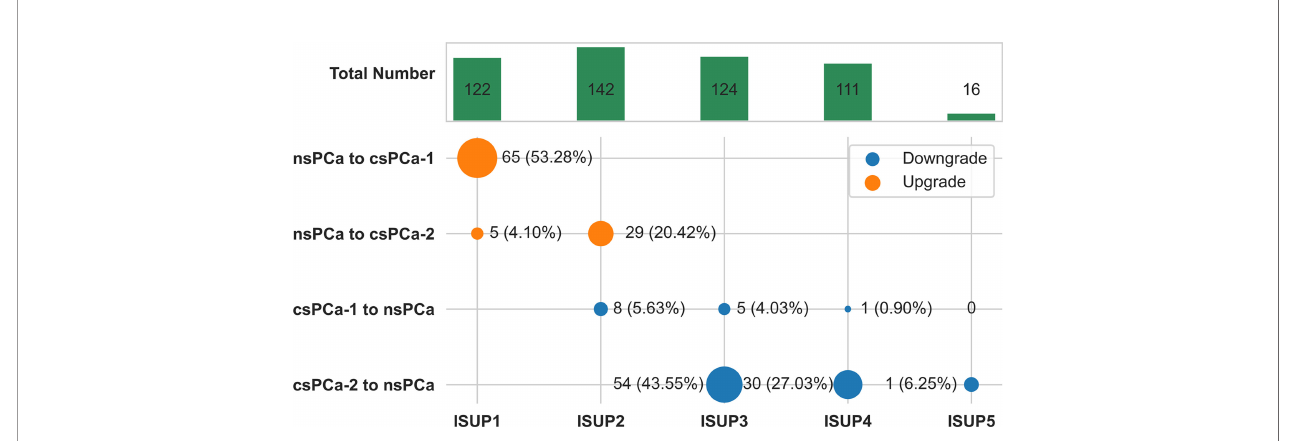
FIGURE 3 | Change plot of clinically signi fi cant pathological upgrade or downgrade from combined biopsy to fi nal radical prostatectomy according to ISUP grade group. csPCa-1 was de fi ned as ISUP grade group 2 or higher tumors. csPCa-2 was de fi ned as ISUP grade group 3 or higher tumors. The size of dot re fl ects the number.csPCa, clinically signi fi cant prostate cancer; nsPCa, non-signi fi cant prostate cancer; ISUP, International Society of Urological Pathology.